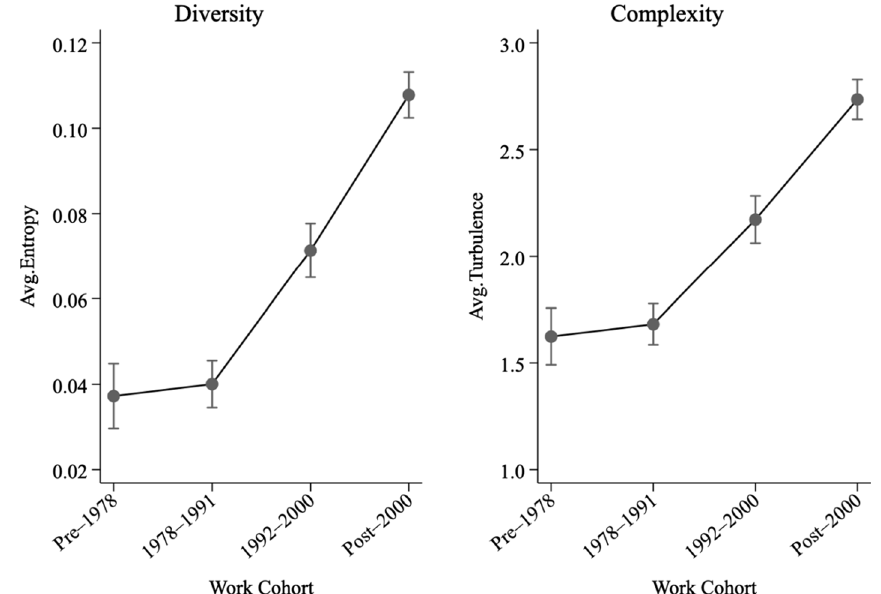
Fig. 3 Main features of work trajectories of different work